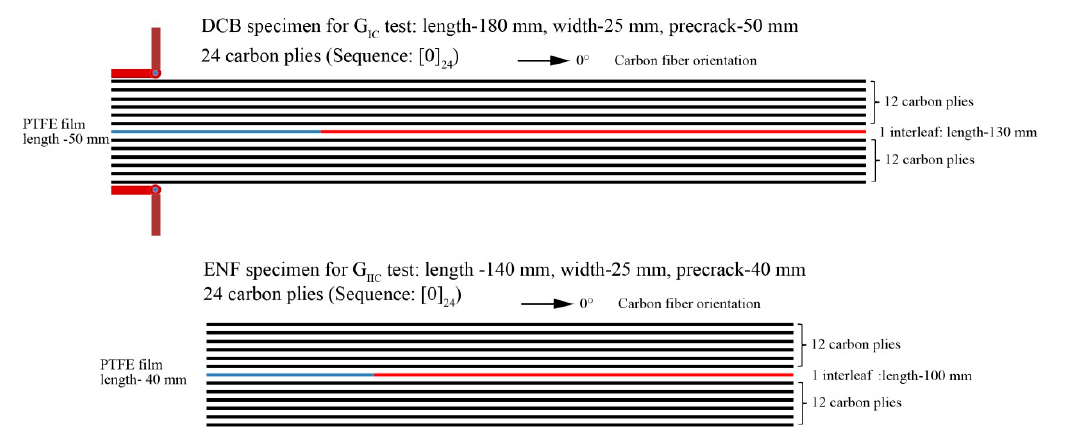
Figure 1. Schematic map of the geometries of the G IC and G IIC specimens.